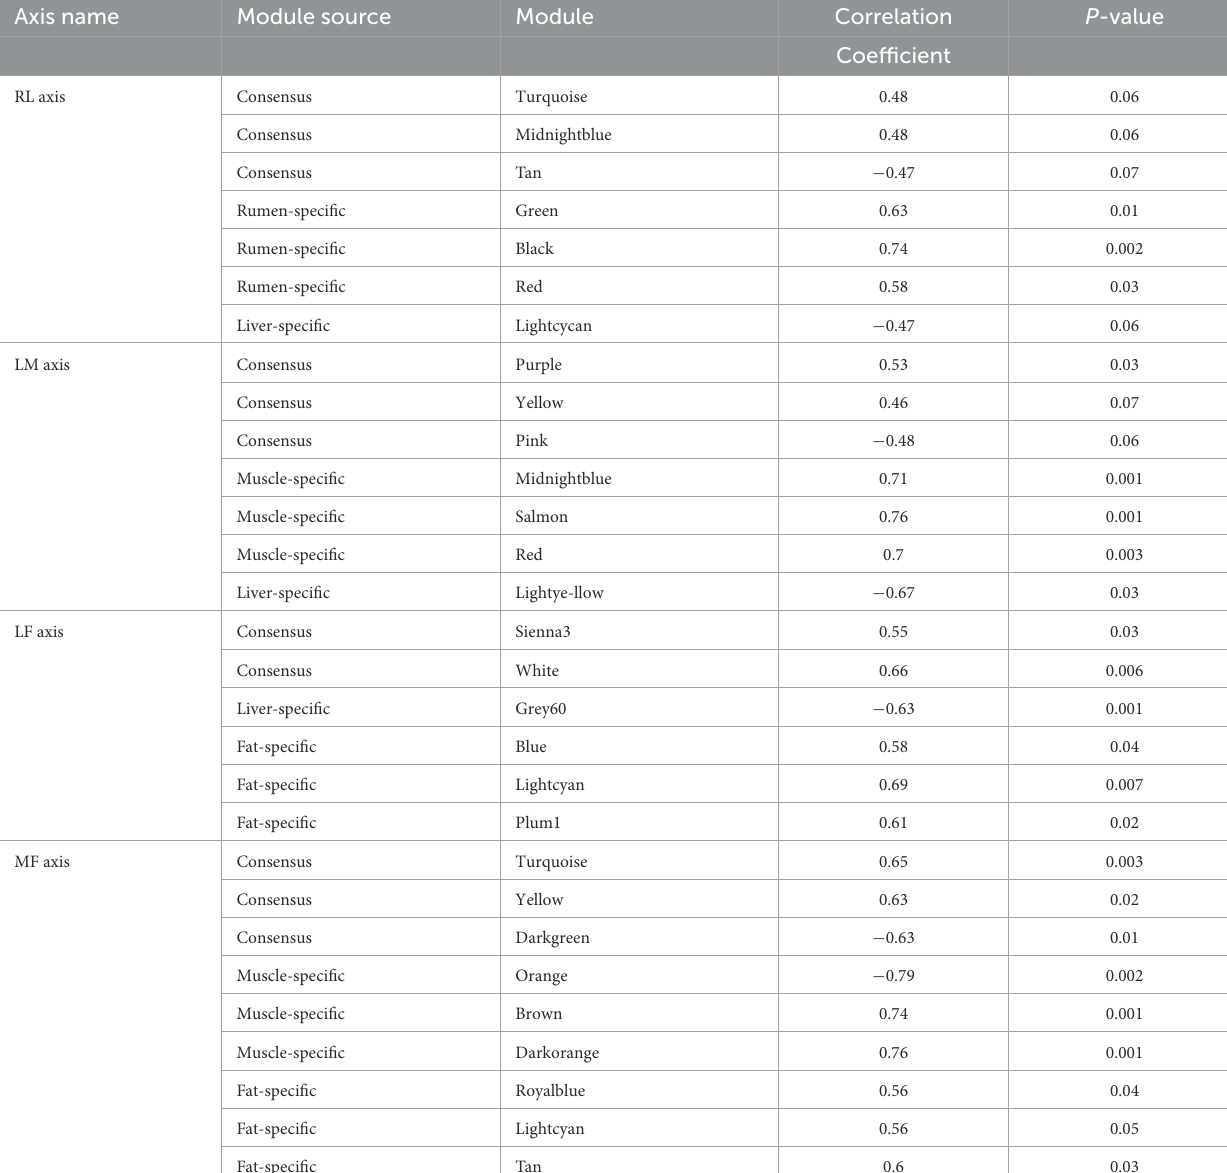
TABLE 1 Names of detected modules and its correlation coefficient in the RLMF regulation axis.